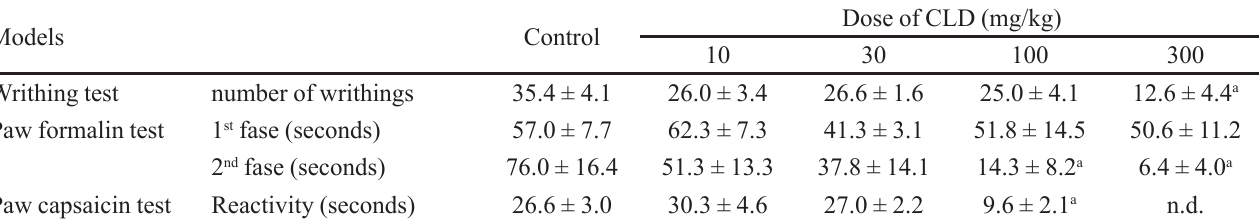
Each group represents the mean for 6 to 10 animals. Significantly different from control group: a p <0.05. Results are presented as mean ± EPM values of the difference in volume (mL) between the carrageenan- and saline-treated paws. The edema inhibition was determined by calculating the area under curve. TABLE II - Analgesic effect of crude extract of L. divaricata (CLD) on the writhing test, paw formalin test and paw capsaicin test in mice Models